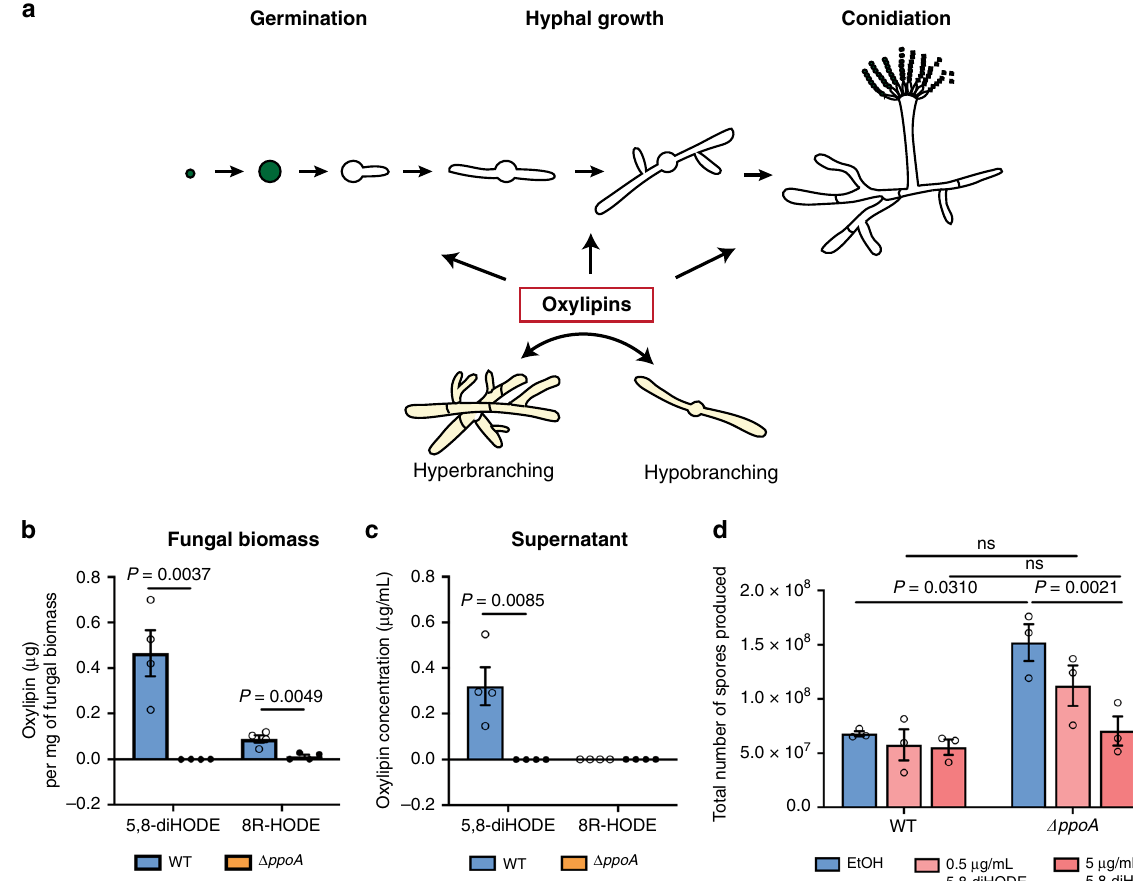
Fig. 1 Production of PpoA oxylipins and complementation of Δ ppoA sporulation phenotype by 5,8-diHODE. a Developmental steps in Aspergillus . Asexual spores swell, germinate, form branched hyphae, and undergo conidiophore development. Different oxylipin signals are proposed to regulate germination, degree of branching, and development of spore-bearing conidiophores. b Quanti fi cation of PpoA oxylipins 5,8-diHODE and 8R-HODE in Af293 WT and Δ ppoA fungal biomass, when cultures were grown at 25 °C for 120 h under constant shaking at 250 rpm ( n = 4). Fungal biomass was separated from supernatant and extracted independently, followed with UHPLC-MS/MS analysis. c Quanti fi cation of PpoA oxylipins 5,8-diHODE and 8R- HODE in Af293 WT and Δ ppoA culture supernatant obtained in the same experiment described in ( b ). d Sporulation quanti fi cation of Af293 WT and Δ ppoA cultures ( n = 3) treated in EtOH, 0.5 µ g/mL and 5 µ g/mL of 5,8-diHODE. Three independent cultures of Af293 WT and Δ ppoA were grown in liquid shaking GMM at 25 °C for 65 h before the addition of 5,8-diHODE or EtOH and cultured up to 120 h before homogenization and spore quanti fi cation. A two-way ANOVA test followed by multiple comparison tests was performed to detect the difference between WT and Δ ppoA in the three different treatment conditions. Multiple two-sided t tests were performed to compare the production of each oxylipin in WT and Δ ppoA in ( a , b ), and two-way ANOVA was performed to test the effect of strain and treatment, followed by Holm – Š ídák multiple comparison tests to compare two strains with the same treatment or two treatments in the same strain in ( c ). All values represent mean ± SEM. ns not signi fi cant ( P >